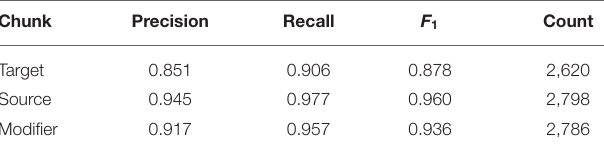
TABLE 3 | Performance of BERT-SEQ on each VA chunk using five-fold cross validation on aVA.